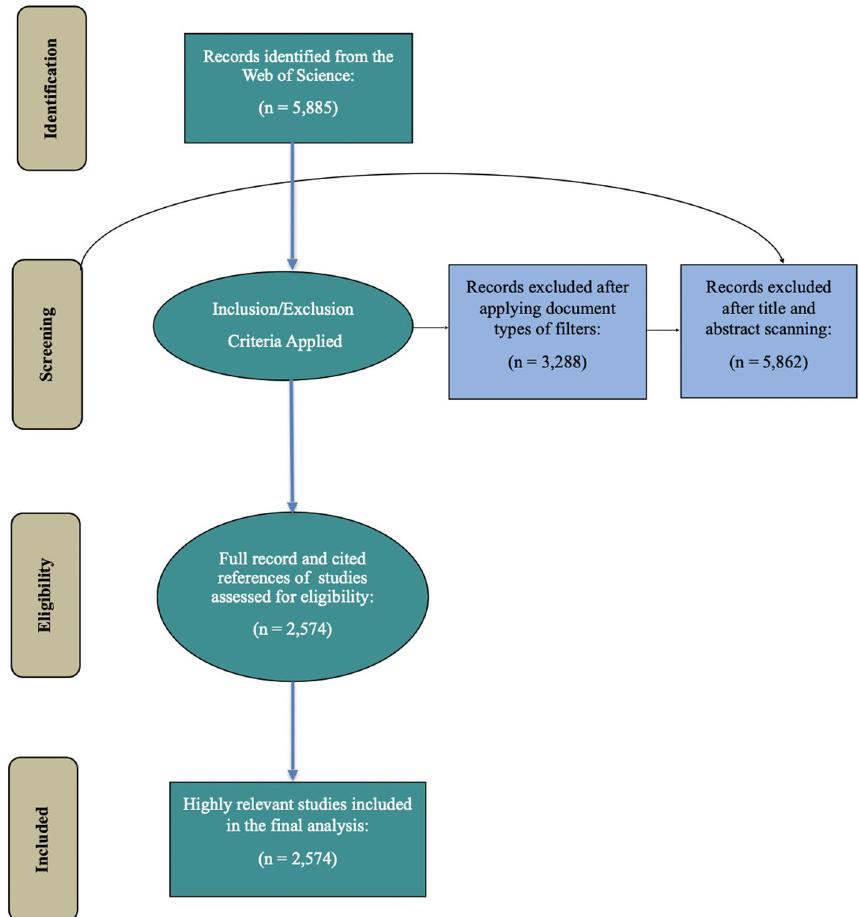
Fig. 1 PRISMA flow diagram, four-phase flowchart of data extraction and filtration